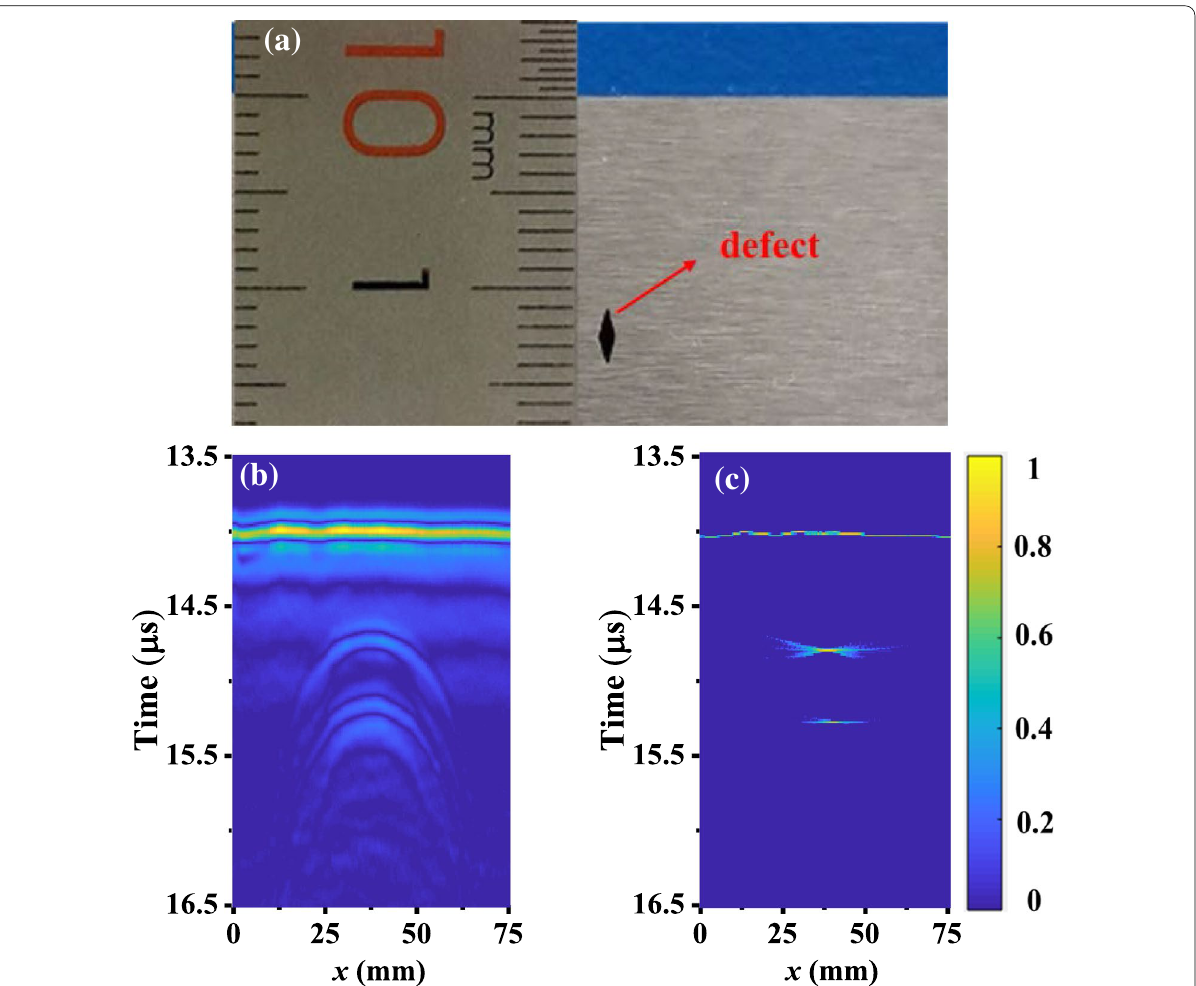
Figure 10 Carbon steel specimen and TOFD images: ( a ) carbon steel specimen with an artificial defect beyond dead zone, ( b ) original TOFD B-scan image, ( c ) reconstructed image by